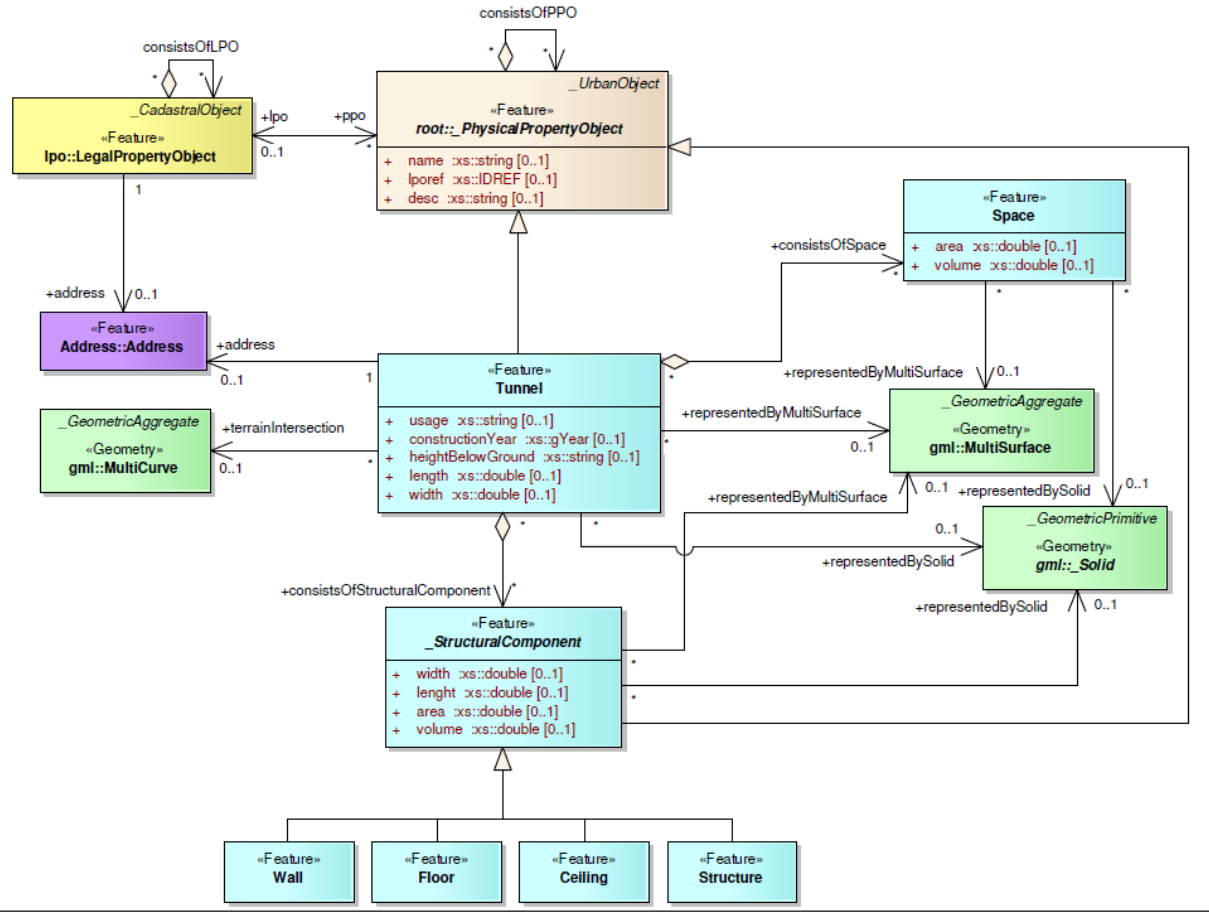
Figure 19. The UML diagram of 3DCDM Tunnel